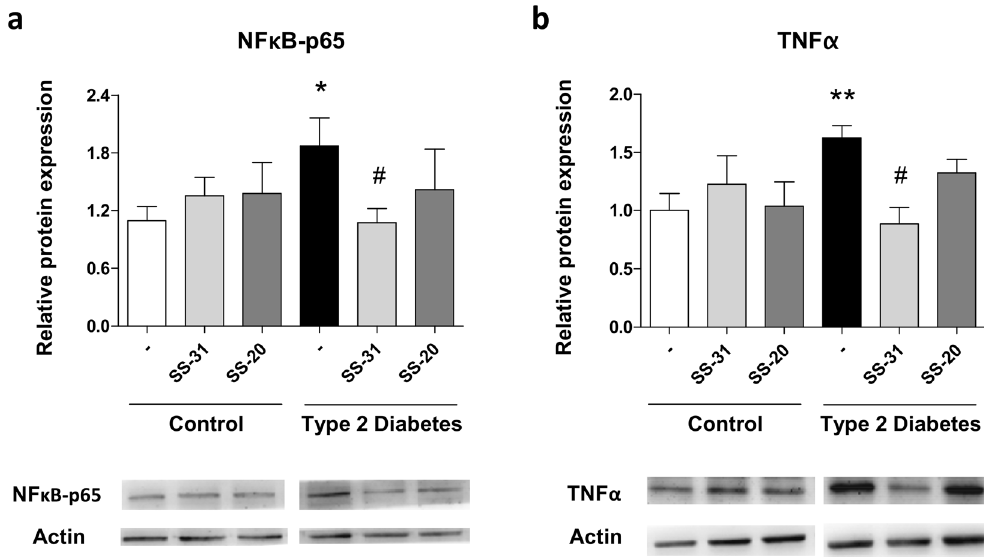
Figure 4. Effects of SS-31 (30 min, 100 nM) on protein expression of NF κ B-p65 and TNF α in type 2 diabetic patients and control subjects ( a ) Protein levels of NF κ B-p65 and representative WB images ( b ) Protein levels of TNF α and representative WB images. Control samples and T2D samples derived from the same experiment on the one hand and blots on the other were processed in parallel. ** p < 0.01 with regard to control group # p < 0.05 vs . non-treated T2D